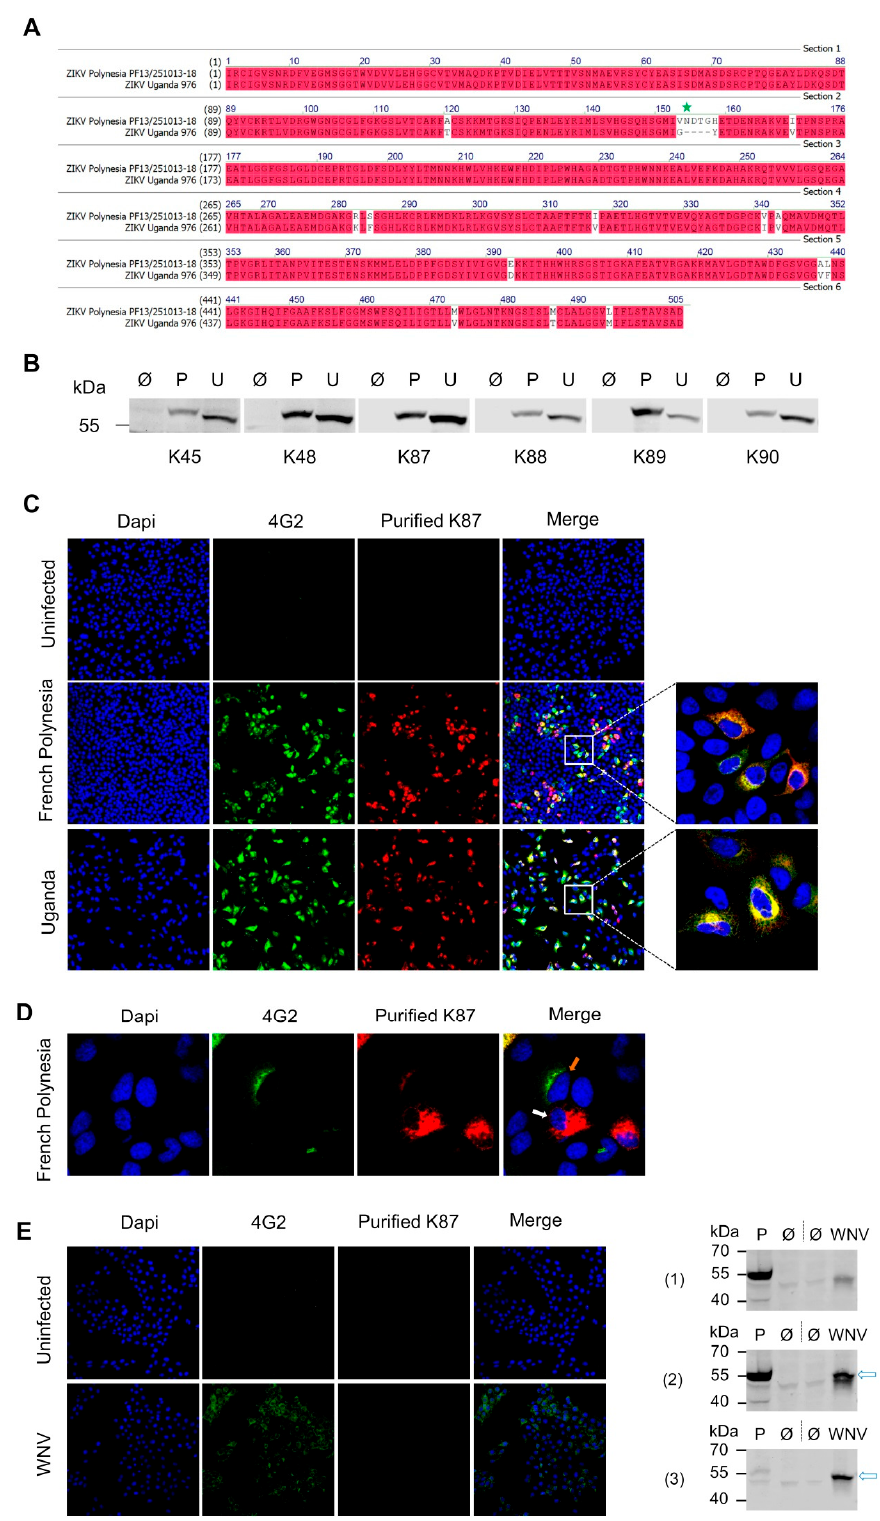
Figure 4. Recognition of ZIKV E protein in infected cells by the purified antibodies. ( A ) Alignment of the amino acid sequence of ZIKV E protein from the Asian (French Polynesia PF13251013-18) and the African strain (Uganda 976). Identical residues are highlighted in red, and the single glycosylation site in ZIKV E protein (N154) in the Asian strain-E protein is marked with green star. Alignment was done using Vector NTI; ( B ) Western blot analysis of lysates from A549 cells, which were either infected